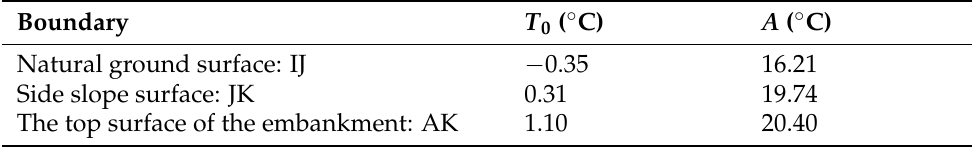
Table 4. Parameters of the temperature boundary